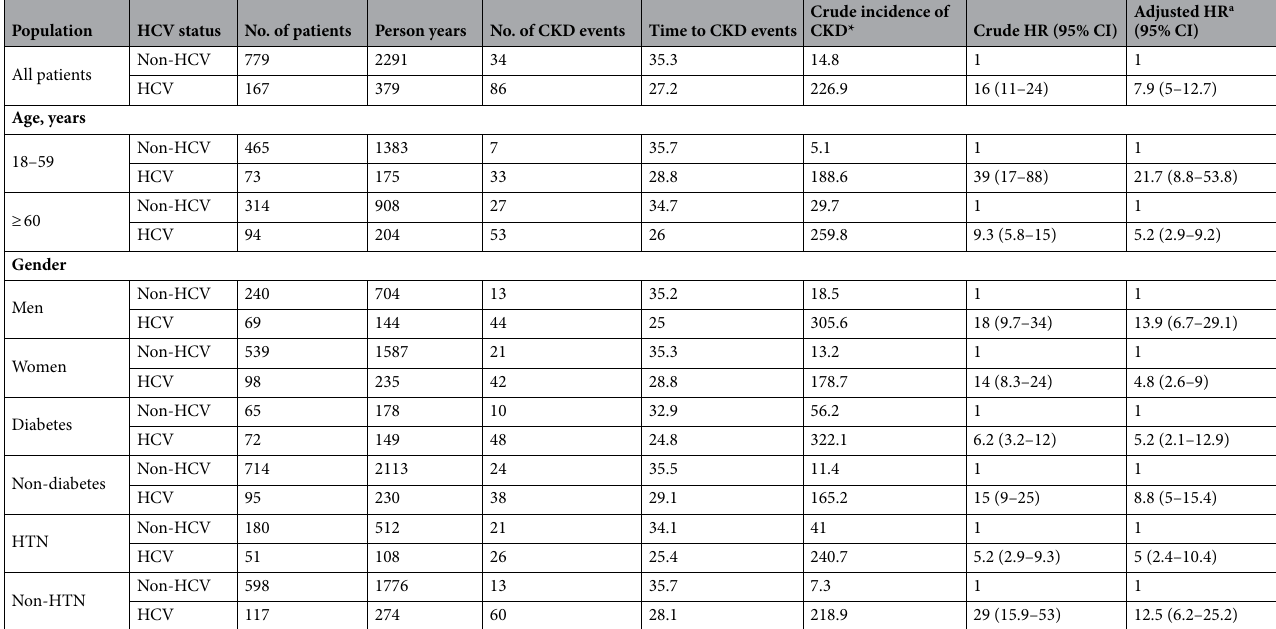
Table 2. Incidence rates and hazard ratio (HR) for CKD according to HCV infection. Time to events was expressed in means (months). *Per 1000 person-years. CKD chronic kidney disease, HCV hepatitis C virus, HR hazard ratio, HTN hypertension. a Adjusted for age, gender, hypertension, diabetes mellitus, baseline eGFR, and urine protein to creatinine ratio.